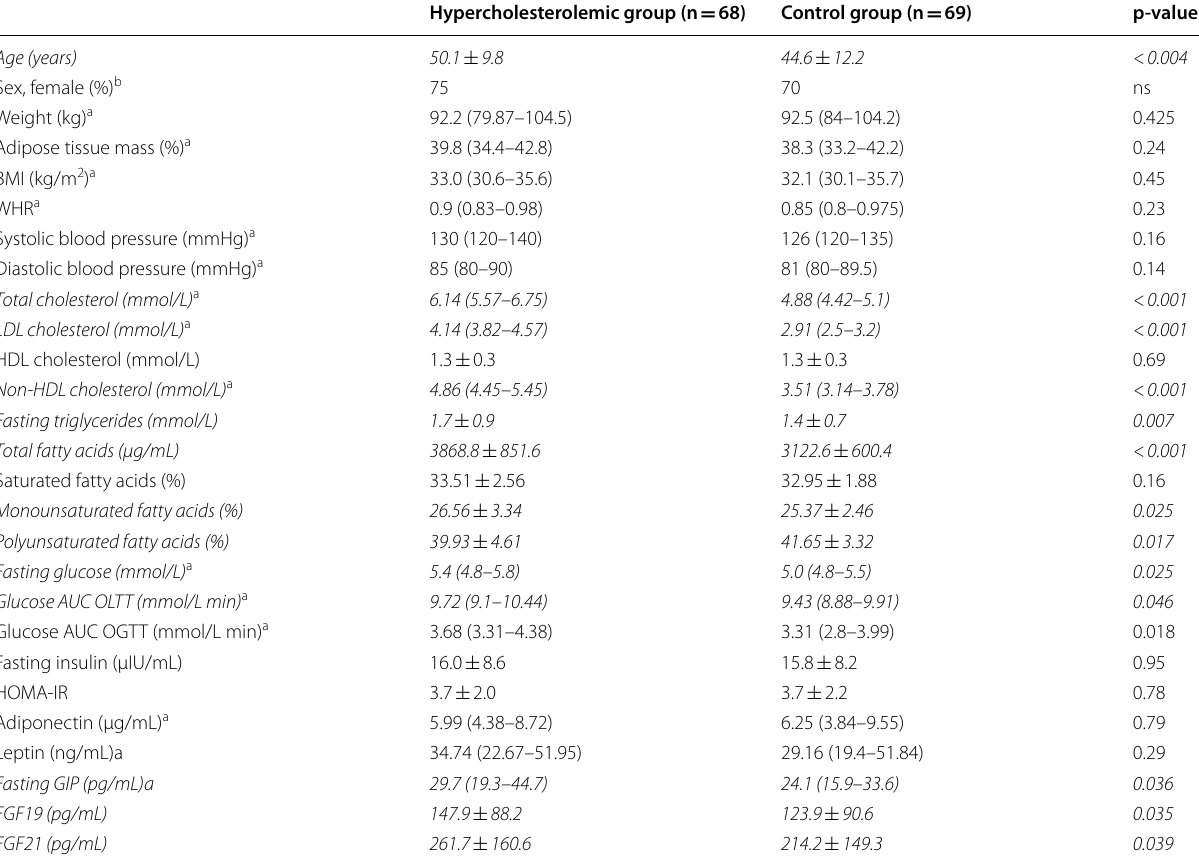
Table 2 Characteristics of subjects with obesity included into the study, comparison of groups according to fasting serum LDL